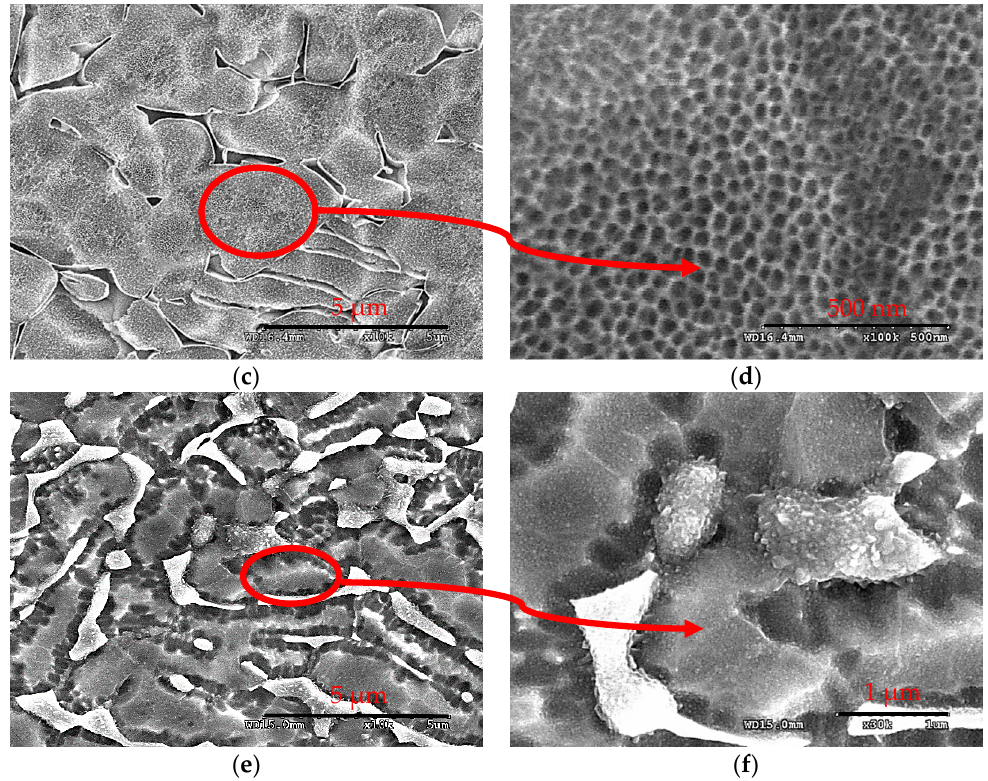
Figure 5. FESEM images of the samples annealed for 1 h at ( a , b ) 200 °C, ( c , d ) 400 °C, and ( e , f ) 600 °C in Ar gas.